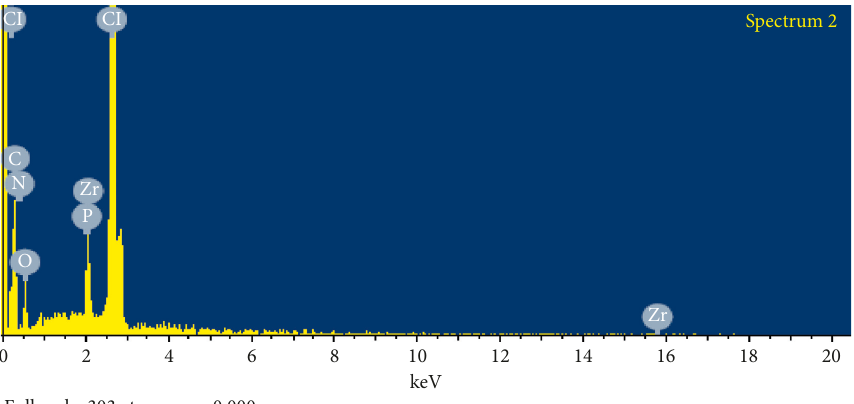
Figure 7: EDX spectrum of PANI/PVC-PEDOT: PSS-ZrP membrane.